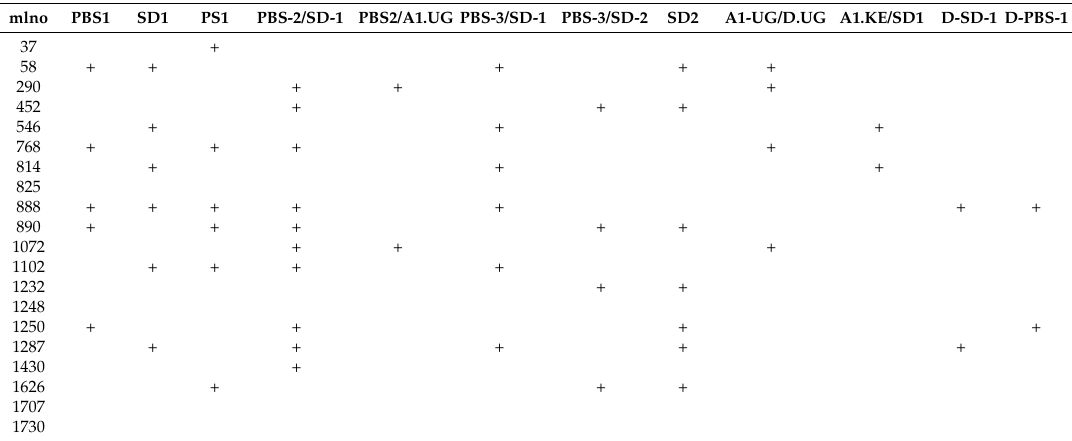
Table 4. Later seroconverters with HIV subtypes, PBS, SD, PS variants that are enriched or only identified in LSC.